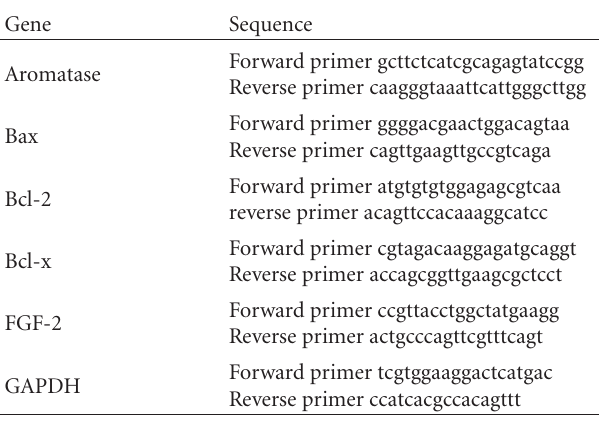
Table 1: Sequence of